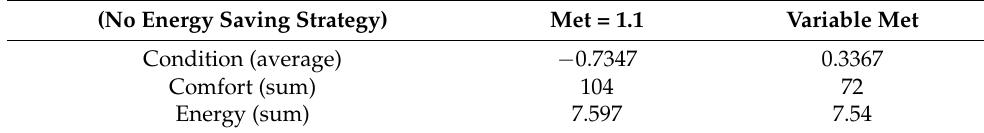
Table 8. Results of first and second simulation.